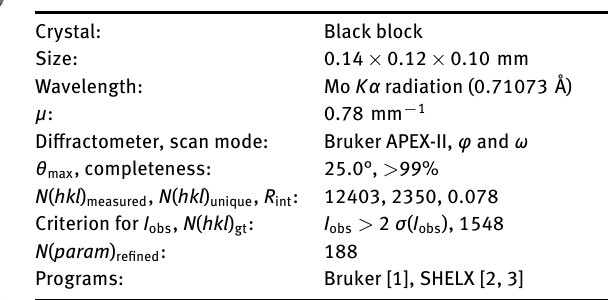
Table 1: Data collection and handling.